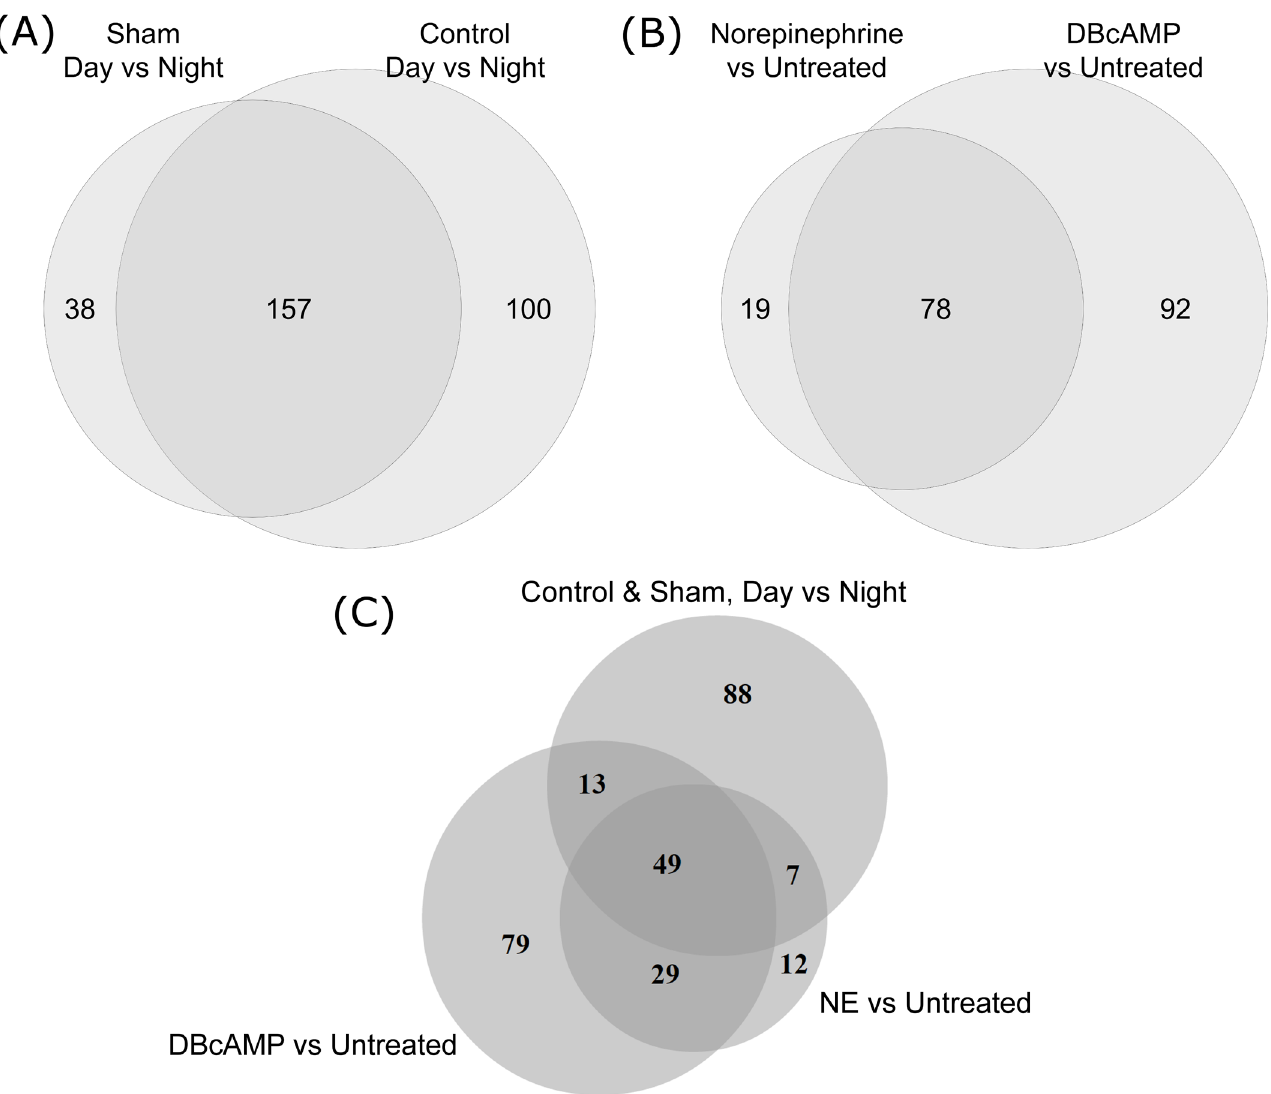
Fig 2. Venn diagrams displaying the overlap between the different differential expression analyses. Diagrams indicate the concordance in the genes found to display strong (FC > 4 in either direction) and statistically significant (adjusted-p < 0.001) differential expression in multiple separate analyses. (a) Comparison of the ( in vivo ) Control and Sham night/day differential expression analyses. (b) Comparison of the ( in vitro ) NE vs untreated and DBcAMP vs untreated differential expression analyses. (c) Comparison of the overlapping region from (a) with the results of the two in vitro analyses from